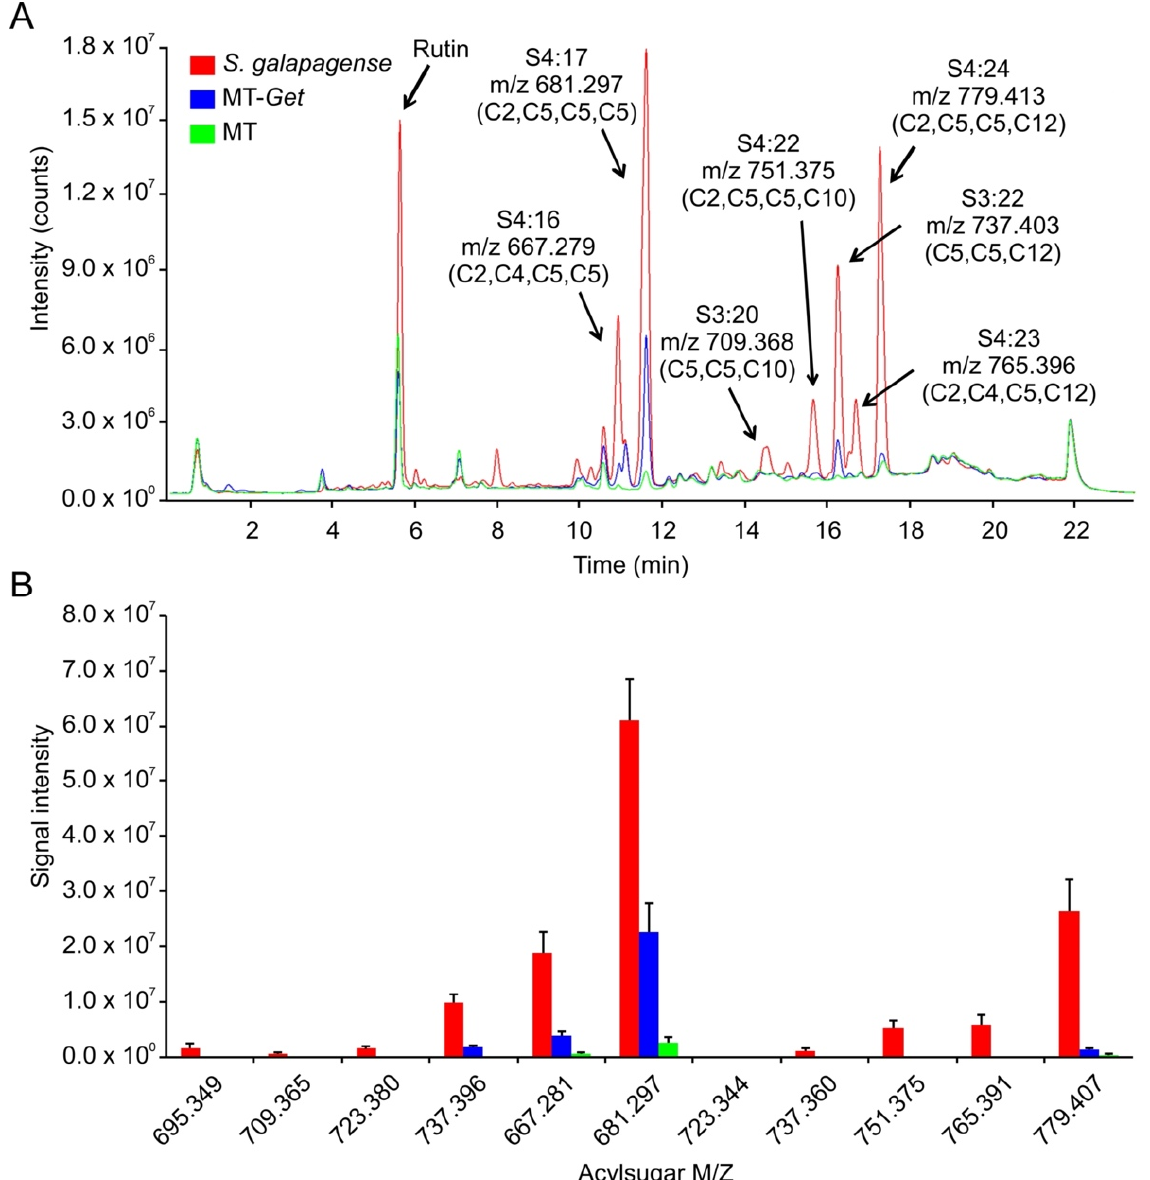
Figure 6. Acylsugar (AS) content in Solanum galapagense LA1401, Micro-Tom (MT), and MT- Get . ( A ) Representative LC-MS/MS chromatogram. Peak area quantifications and statics are shown in Table 1. ( B ) Signal intensity for each of the AS analyzed in the three genotypes. The symbols used to classify acylsugars are detailed in the Introduction section. Table 1. Peak areas from ion chromatograms (LC-MS/MS) of acylsugars from S. galapagense , MT- Get , and MT.